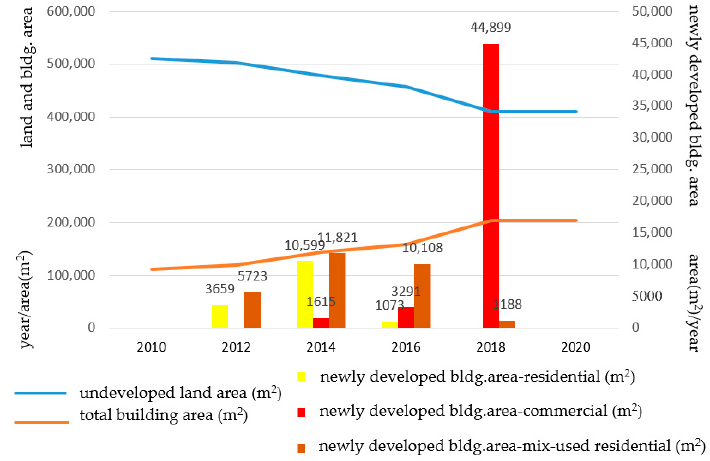
Figure 9. Changed area of lands and newly added or developed area of building types around Hengshan Calligraphy Park.